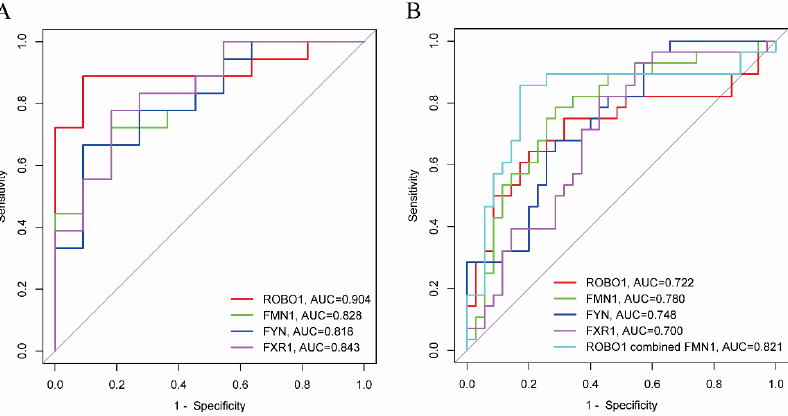
Figure 5. ROC curves of hub genes predicting metastasis. ( A ) ROC curves of ROBO1, FMN1, FYN and FXR1 in GSE 27831. ( B ) ROC curves of ROBO1, FMN1, FYN, FXR1 and ROBO1 combined with FMN1 in GSE22138.